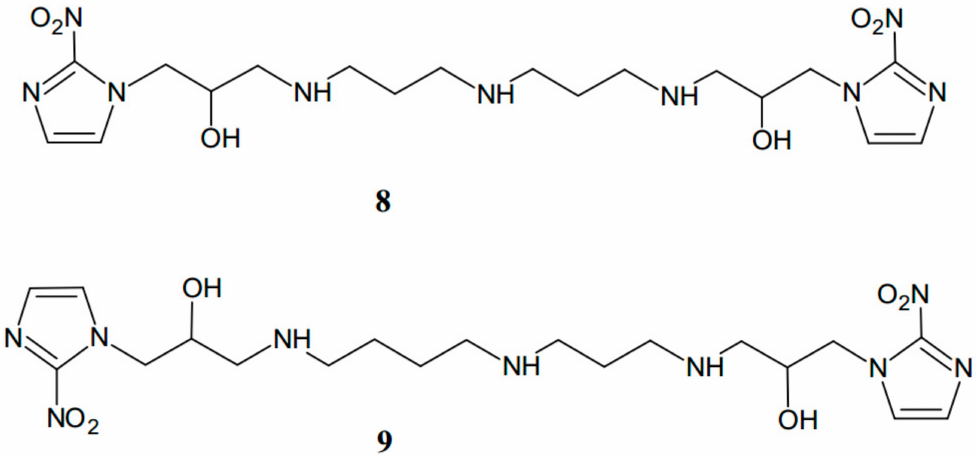
Figure 4. Structures of N 1 , N 7 -bis-derivatised norspermidine-nitroimidazole conjugate ( 8 ) and N 1 , N 8 -bis-derivatised spermidine-nitroimidazole conjugate ( 9 ).